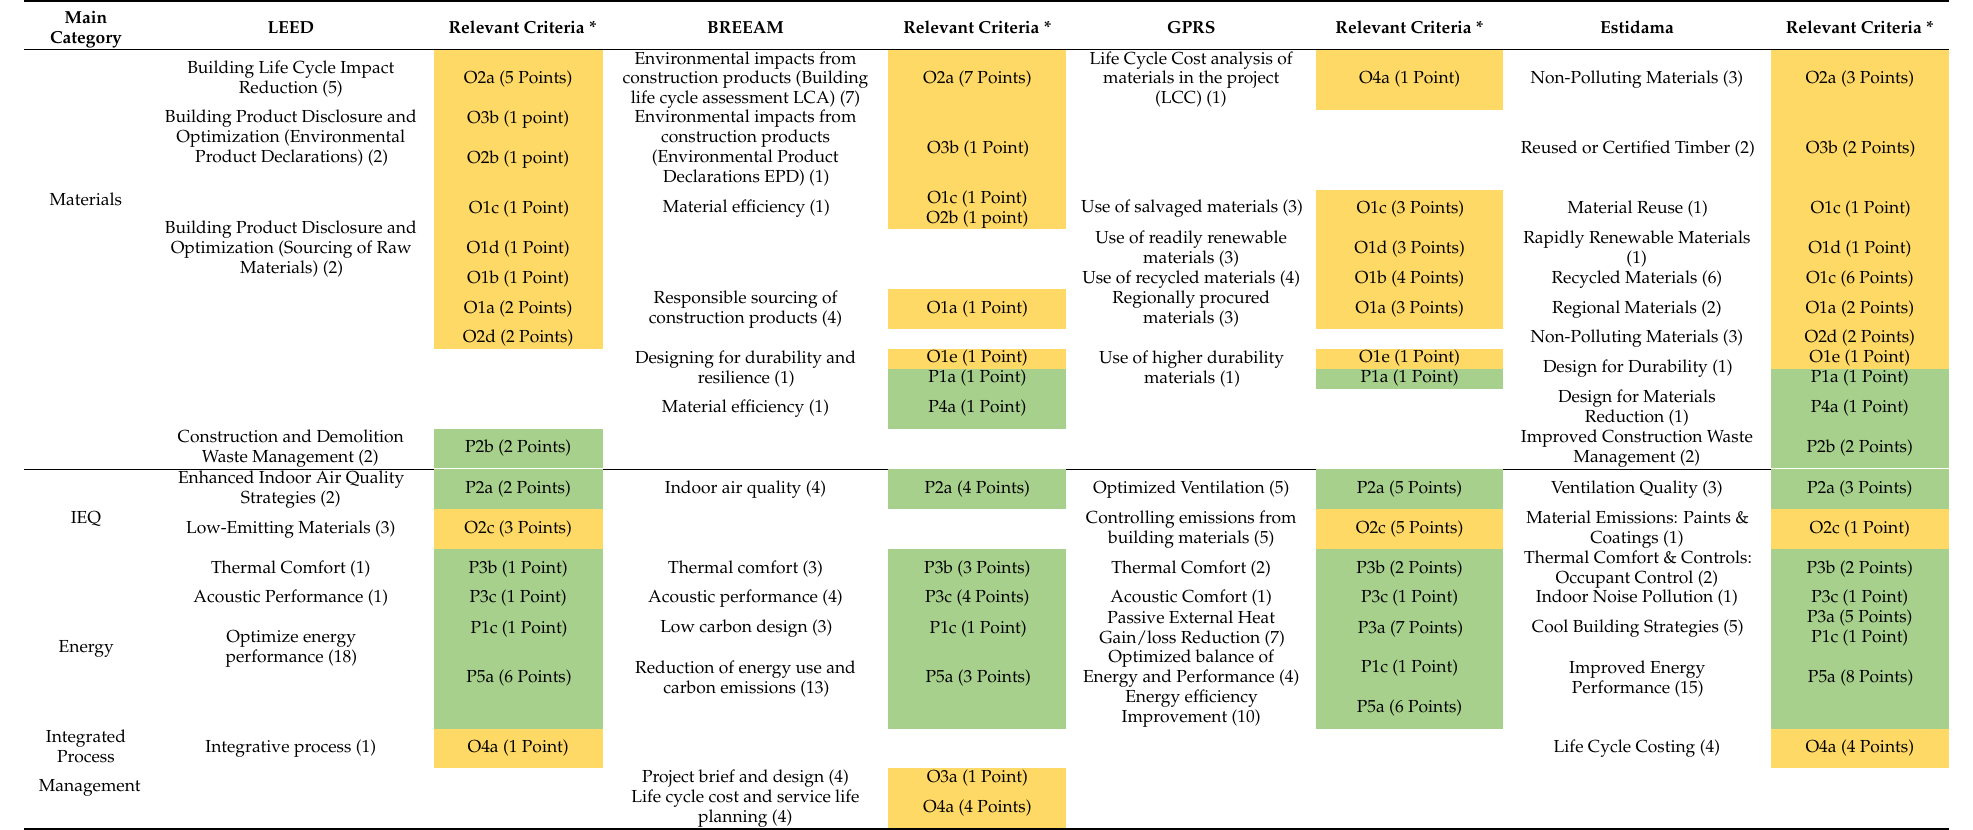
Table 2. Sub-criteria credits based on selected green rating